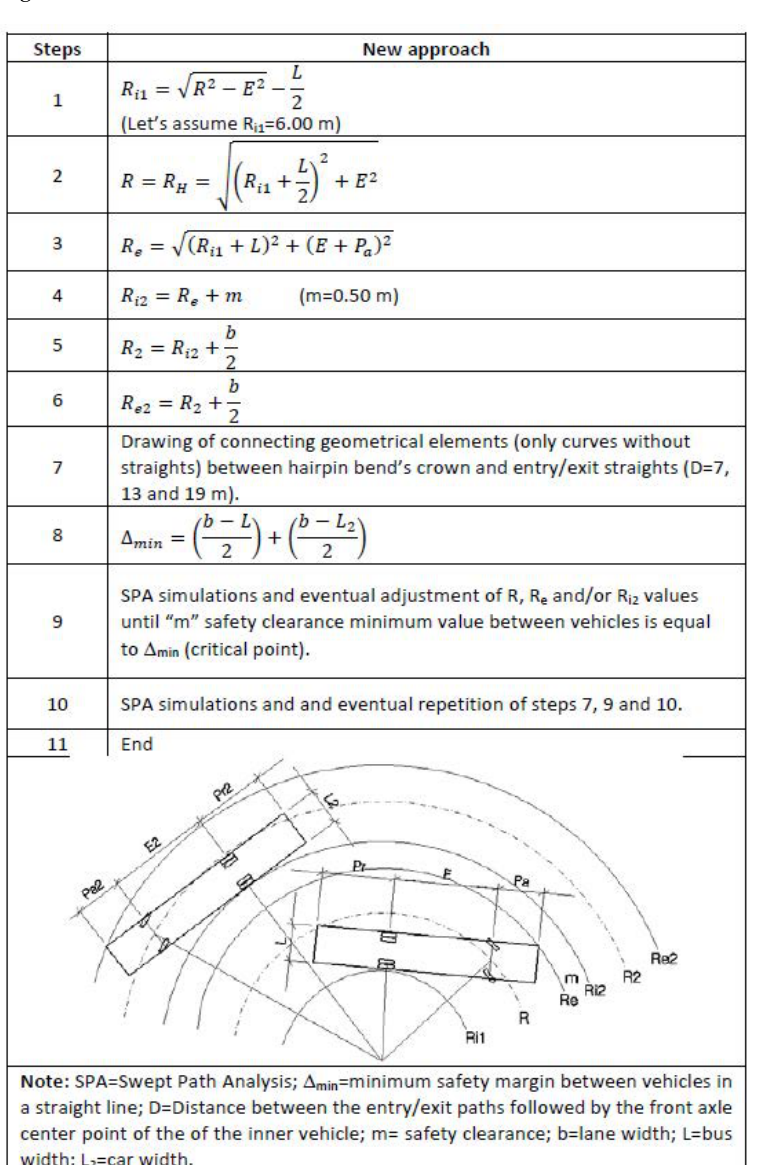
Figure 4. Bend insertion of two two-axle vehicles: new